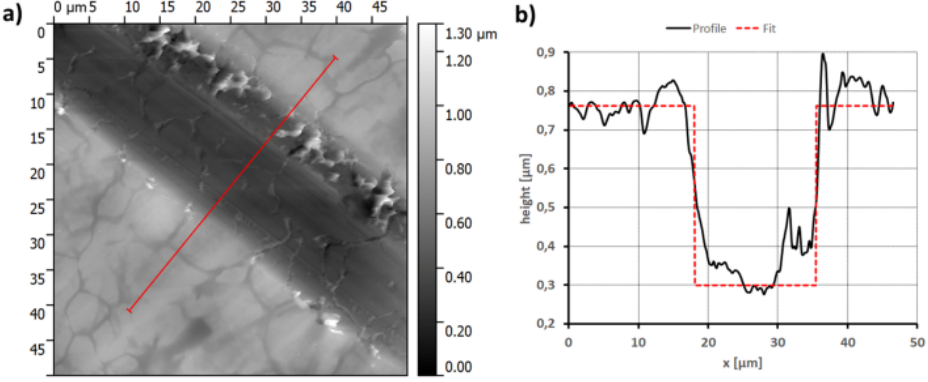
Figure 3. ( a ) Typical AFM image of the scratched layer, ( b ) extracted profile with fitted step curve. Table 2. Thickness of the RPTMS